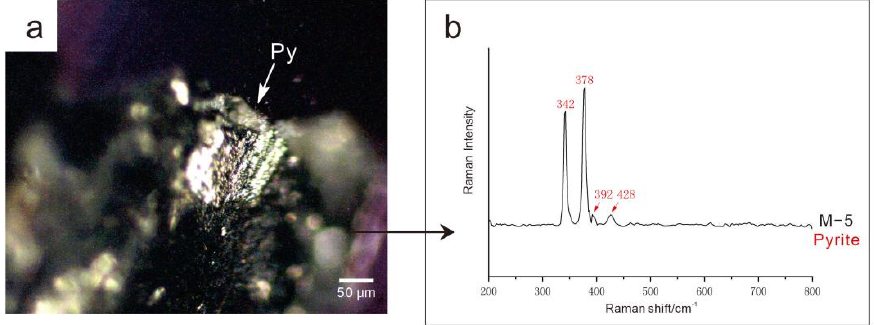
Figure 10. ( a ) Pyrite inclusion in Myanmarese spinel (M − 5) and ( b ) its (M − 5) Raman spectrum. Black, slightly transparent to opaque massive rutile inclusions are commonly found in spinels from Tajikistan. Raman analyses revealed that the black opaque mineral inclusions (Figure 11a) in Tajikistani spinel (T-5) were rutile (peaks at 248 cm − 1 , 437 cm − 1 , and 611 cm − 1 ) (Figure 11b).